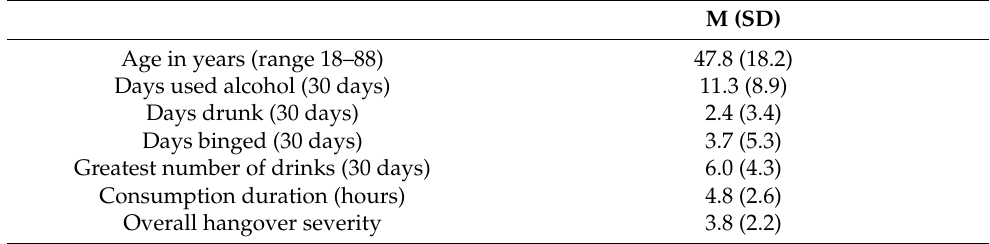
Table 1. Means and standard deviations for participant demographic and drinking characteristics.